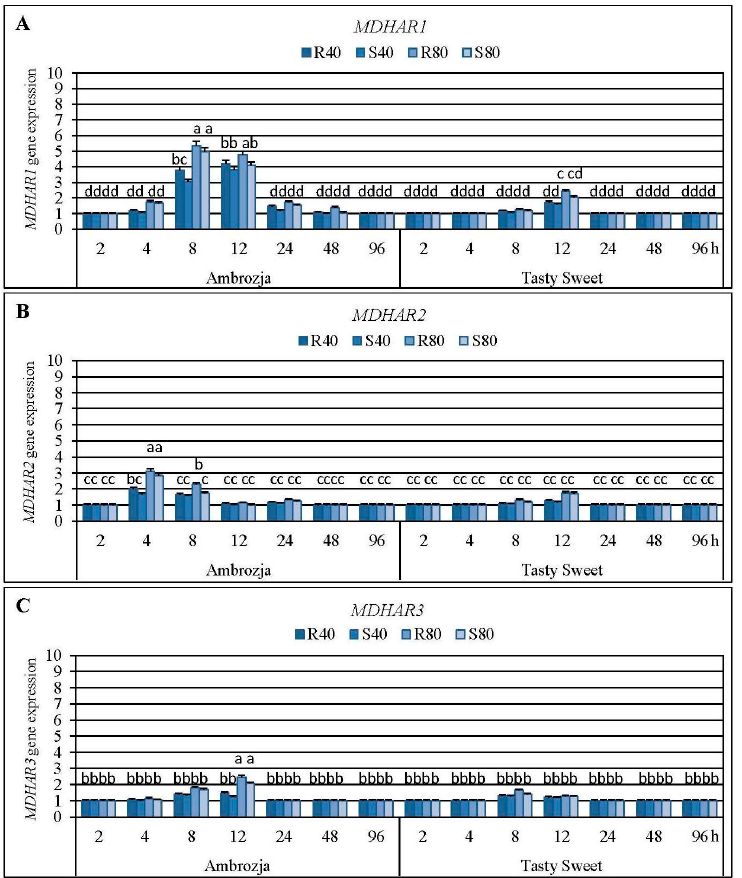
Figure 6. Influence of the cereal aphid’s infestation on relative expression of MDHAR1 ( A ), MDHAR2 ( B ) and MDHAR3 ( C ) genes in the seedlings of Ambrozja and Tasty Sweet maize varieties (first phase of the experiments). R40, R80—maize plants of a certain genotype infested with 40 or 80 R. padi females per seedling, accordingly; S40, S80—maize plants of a certain genotype infested with 40 or 80 S. avenae females per seedling, respectively. All data are presented as the mean (±SD) of three independent biotests, and significant differences in abundance of the monodehydroascorbate reductase ( MDHAR ) transcripts are denoted by different letters ( p < 0.05; post-hoc Tukey’s test).